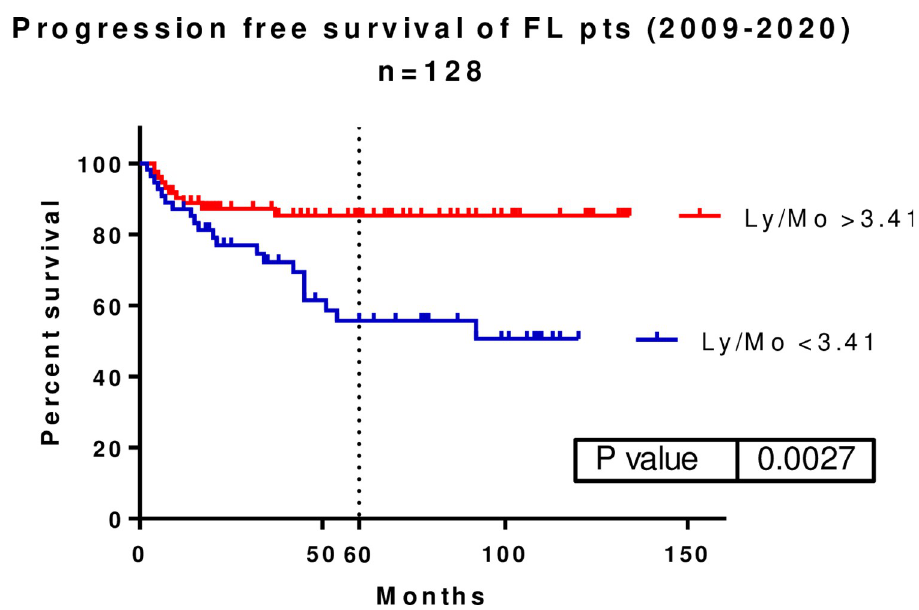
Fig 4. Lymphocyte/ monocyte (Ly/Mo) ratio of 3.41 drawn at diagnosis also significantly predicted PFS (p = 0.0027, HR: 2.997, 95% CI: 1.463–6.142). Five-year PFS was 85.30 vs. 55.73%. PFS–progression-free survival, Ly– lymphocyte, Mo–monocyte.